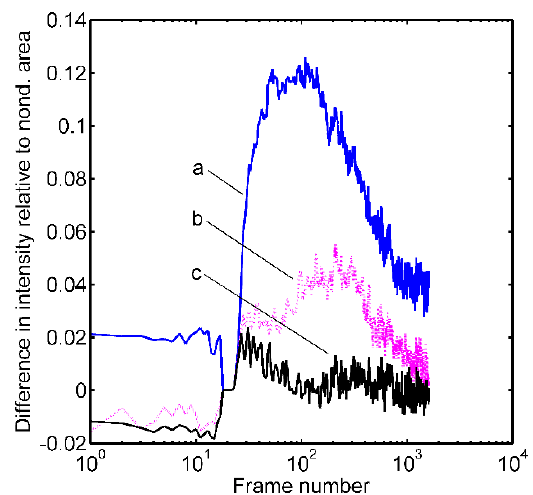
Figure 12. Change in mathematical expectation of pixel intensity in ∅ = 5 mm defect area along vertical A at depths: a) h = 3.7 mm, b) h = 3.4 mm and c) h = 2.7 mm.